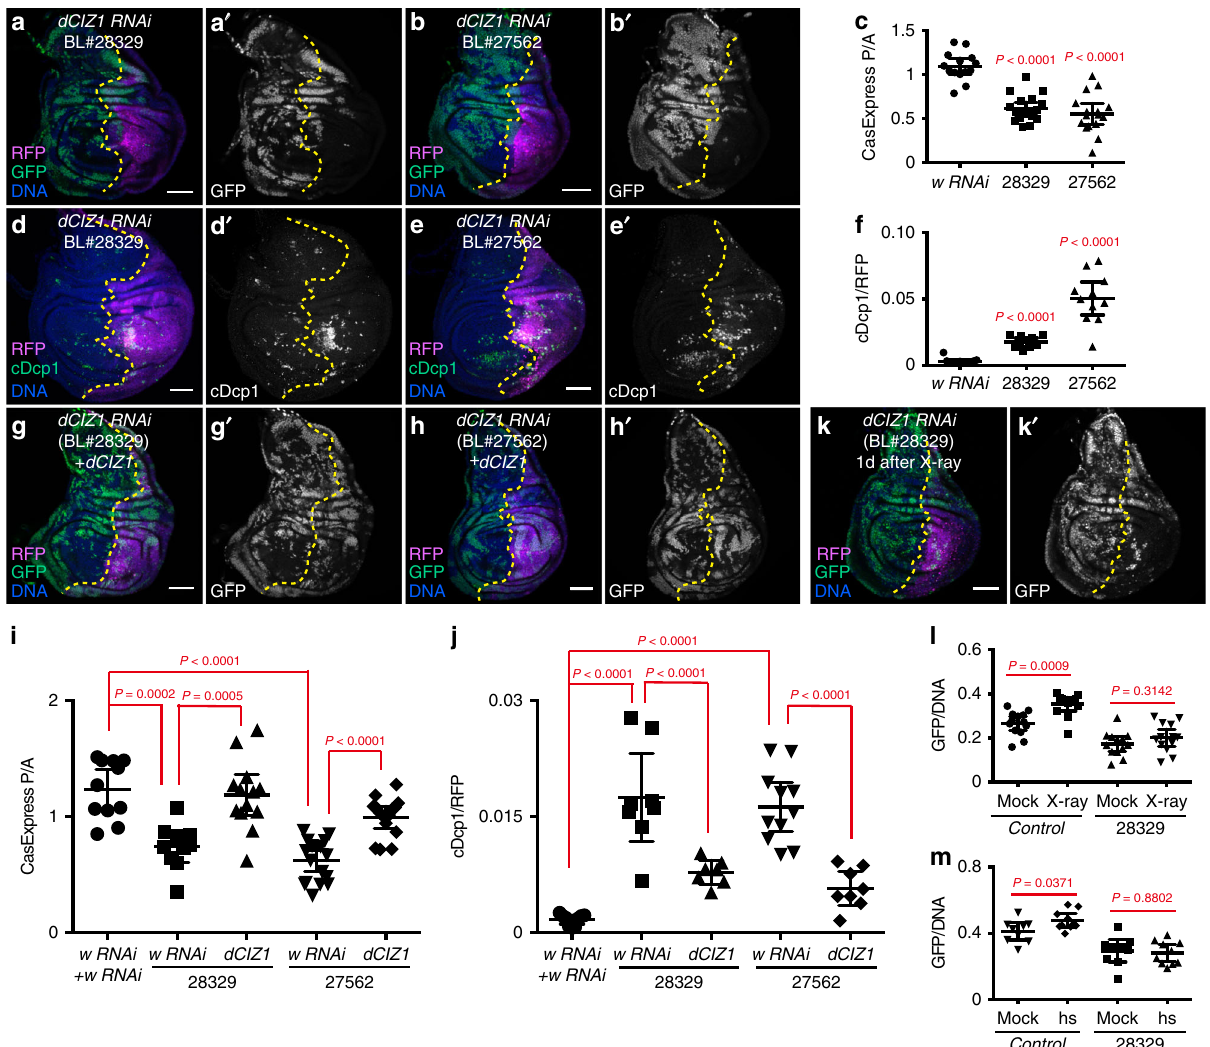
Fig. 5 dCIZ1 is essential for survival from executioner caspase activation. ( a , b ) Expression of two different RNAi against dCIZ1 reduced CasExpress activation (GFP). ( c ) Quanti fi cation of CasExpress activation in discs expressing enGal4 , UAS-RFP , L-CasExpress , L-trace , and w RNAi ( n = 14) or